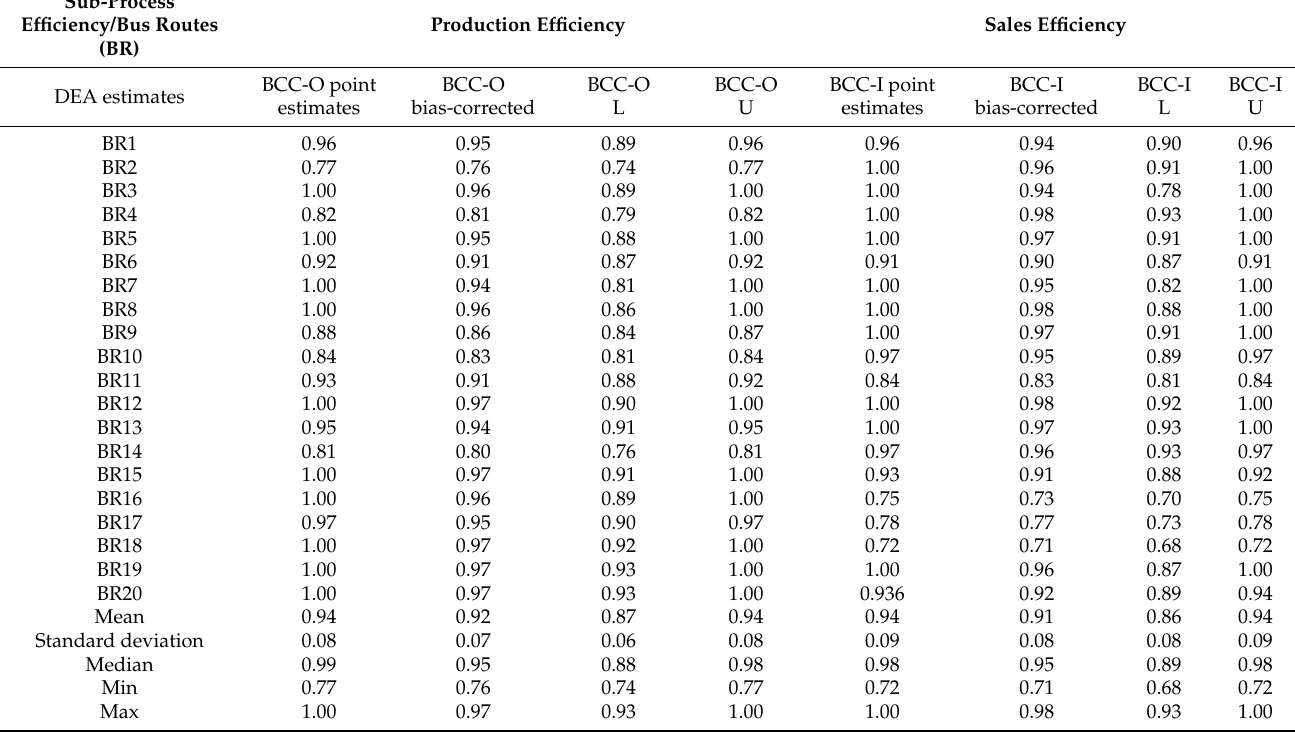
Table 2. Bus route efficiency measures for production and sales process and descriptive statistics. Sub-Process Efficiency/Bus